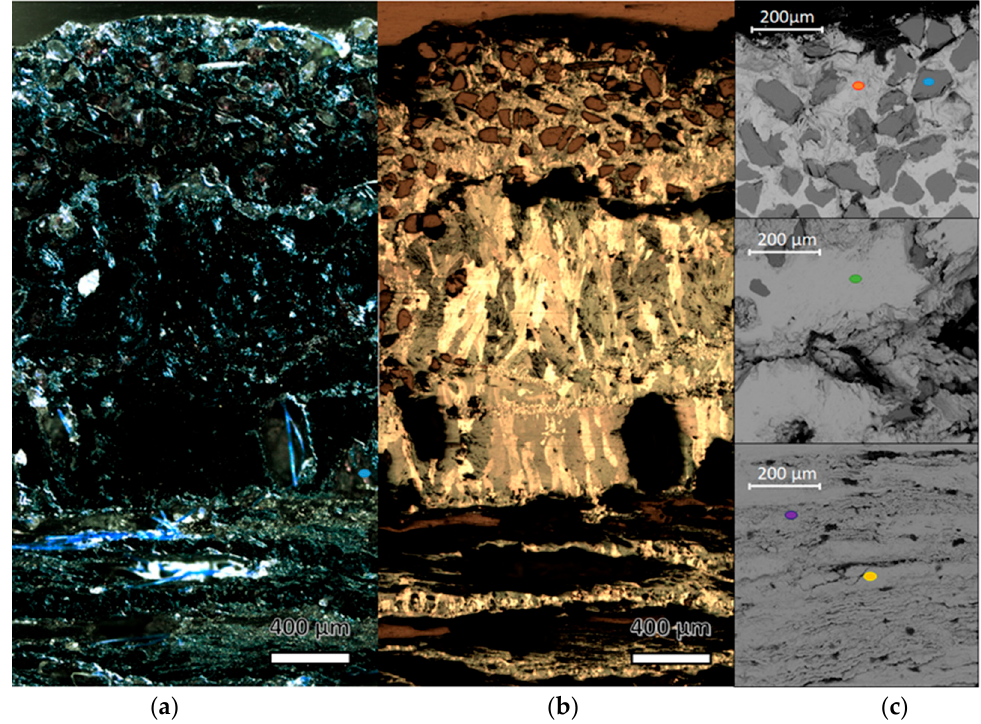
Figure 5. Images acquired from an optical microscope in ( a ) polarised light and ( b ) bright field; ( c ) SEM micrographs of the nail head cross-section. The coloured points indicate the spots analysed by EDS and the relative spectrum is reported in Figure S6 of SI.